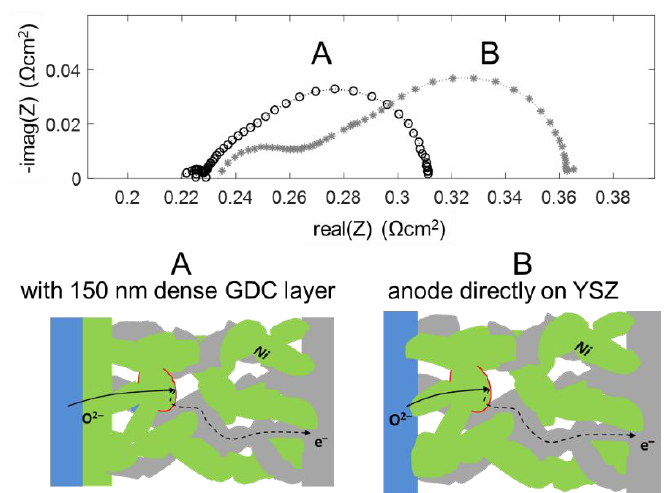
Figure 13. comparison of impedance spectra of 7.5 µm thick Ni/GDC electrodes with ( A ) and without ( B ) a dense GDC10 buffer layer between electrode and electrolyte, measured in 275 mbar H 2 + 25 mbar H 2 O at 750 °C.